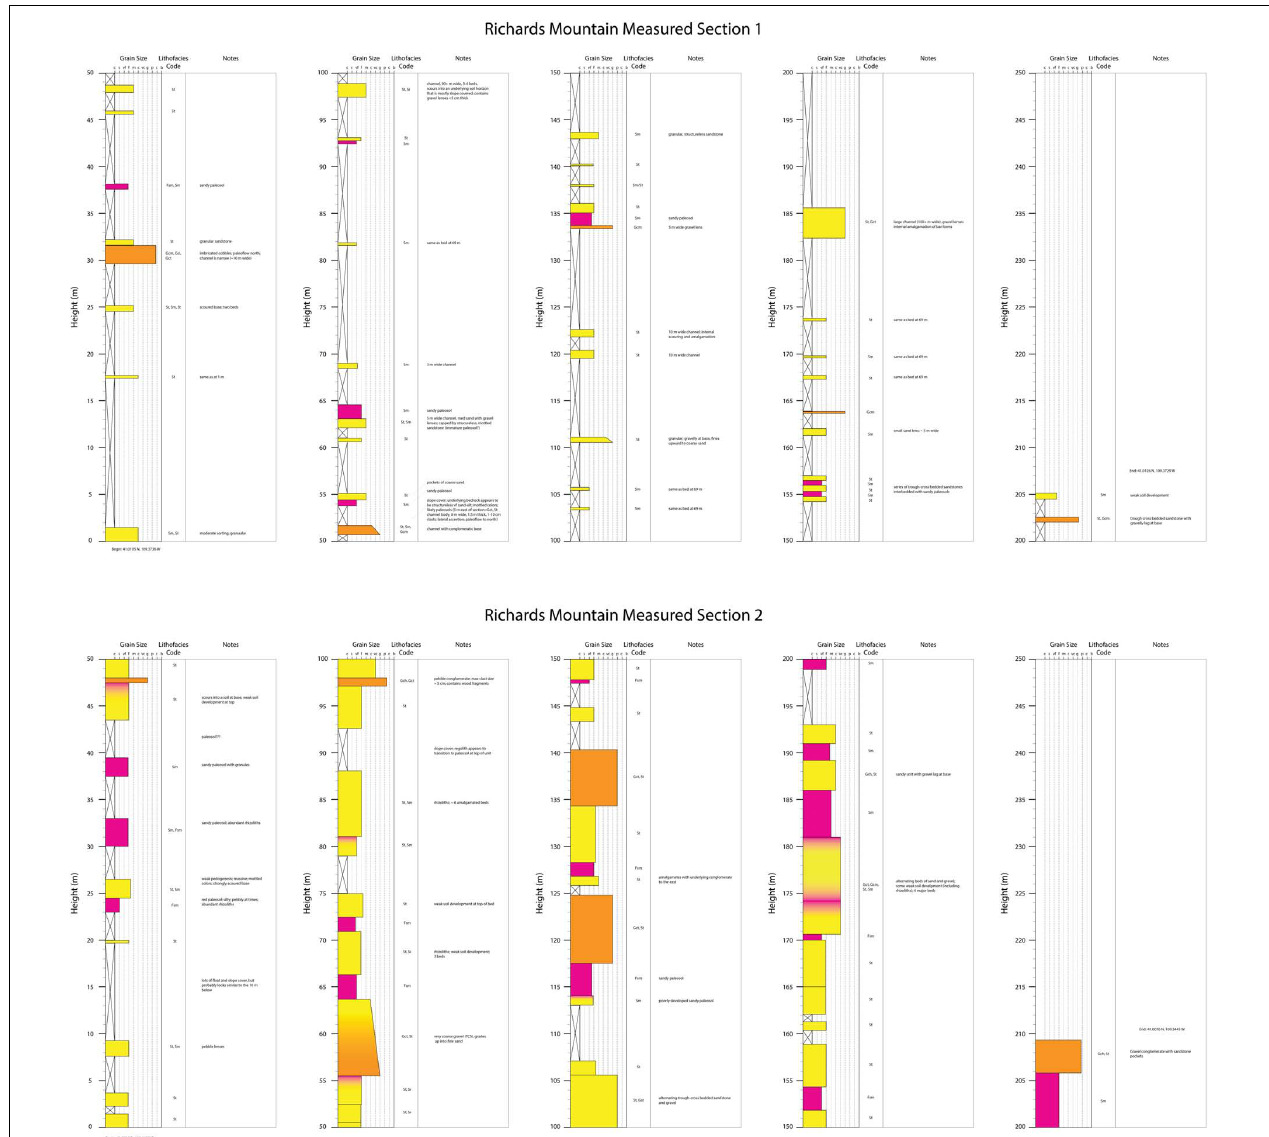
FIGURE 7 | Details of sedimentary logs measured at Richards Mountain by the authors. Additional sedimentary logs used for interpreting the deposits at Richards Mountain can be found in Crews (1985). Facies codes represent the following: Fsm = Fine-grained, massive/structureless. Usually paleosols. Sm = massive/structureless sandstone. Usually indicates bioturbation and early pedogenesis in these logs. St = trough-cross-stratified sandstone. Sr = ripple-cross-stratified sandstone. Gcm = clast-supported massive/structureless conglomerates. Gct = clast-supported trough-cross-stratified conglomerates. Gci = clast-supported, imbricated conglomerates, Gch = clast-supported, horizontally bedded